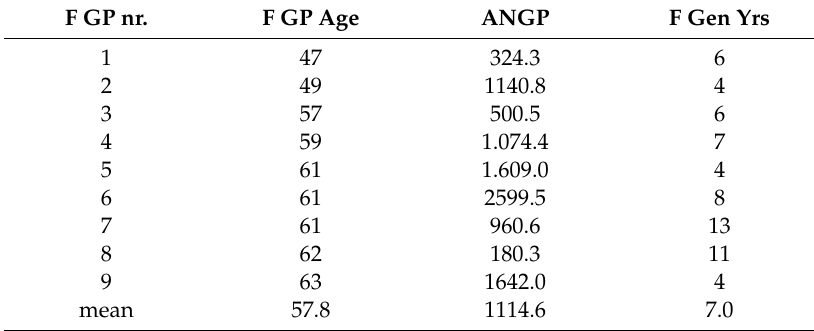
Table 1. Generic drug prescription of female GPs ( n =